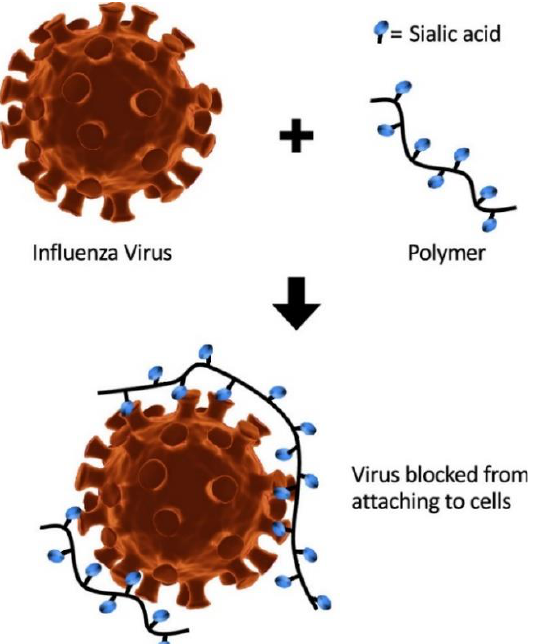
Figure 6. Inhibition of influenza by polyvalent SA-containing polymers. SA side chains bind to HA spikes on influenza’s surface, rendering the virus unable to bind to cells. Adapted with permission from ref. [83], published by ACS, 2020.